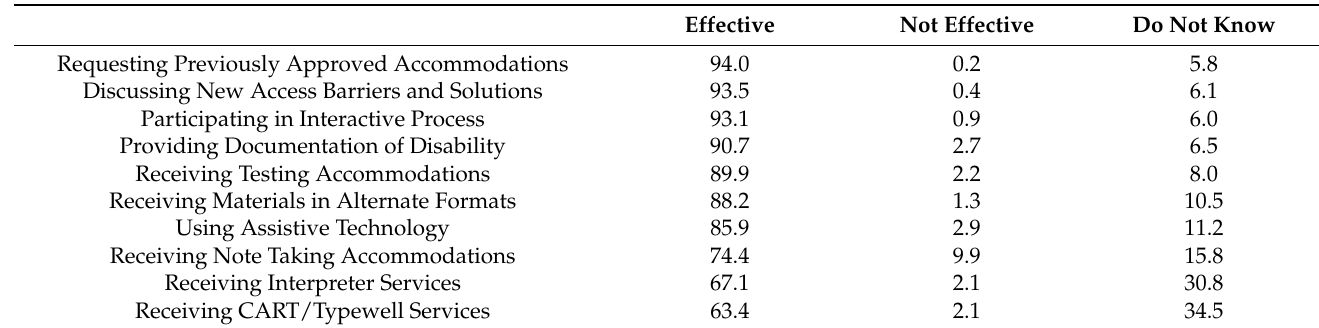
Table 5. Disability resource professionals’ perceived effectiveness of support service use for students with disabilities (nine months into pandemic, n = 631), by